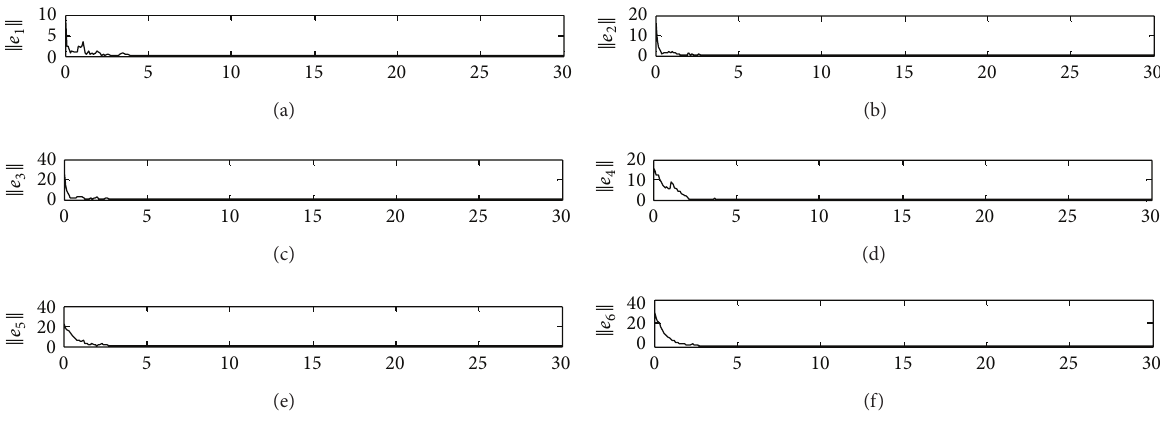
Figure 2: Synchronization errors with adaptive feedback controllers